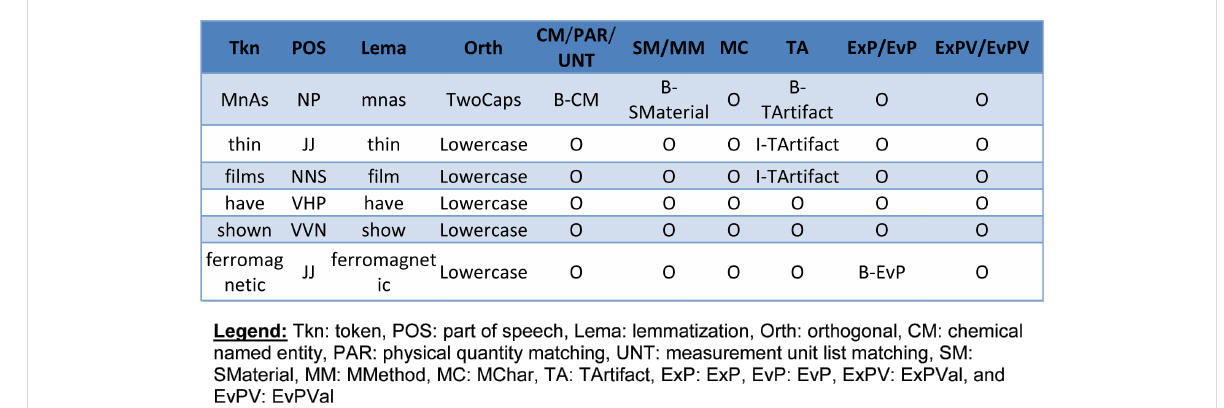
Figure 4: Example of CRF++ input data.